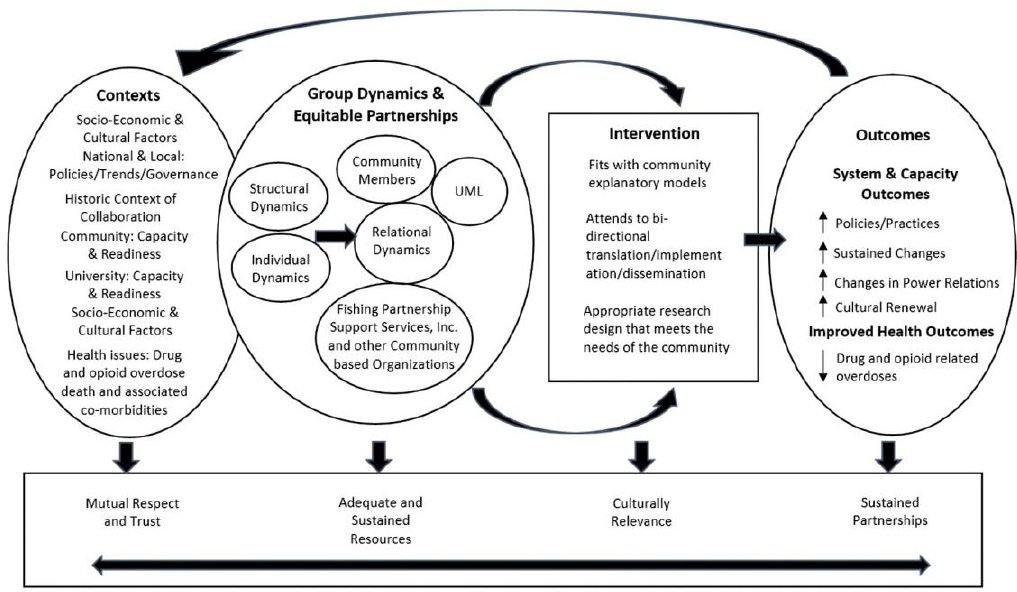
Figure 1. Community-based participatory research framework .